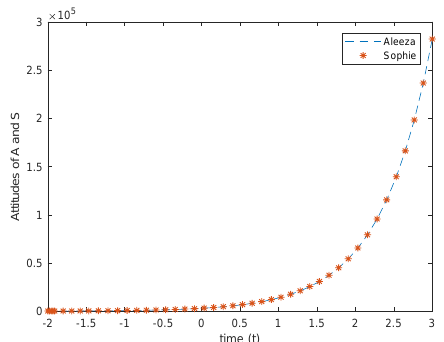
Figure 3. Line graph for differential Equation (4).